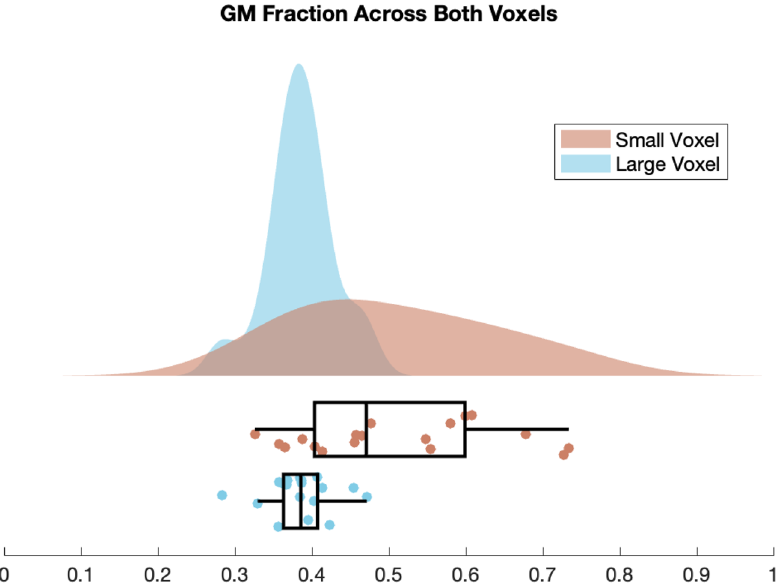
Figure 4. Raincloud plot of GM fraction as proportion of total tissue in the small voxel (light pink, top box plot) and large voxel (blue, bottom box plot). GM fraction calculated as GM/(GM + WM). Raw data values are displayed below the probability distribution: a histogram smoothed with a kernel of 1 mm. The boxplot illustrates the interquartile range with the whiskers being 1.5 × interquartile range. Developed using 19